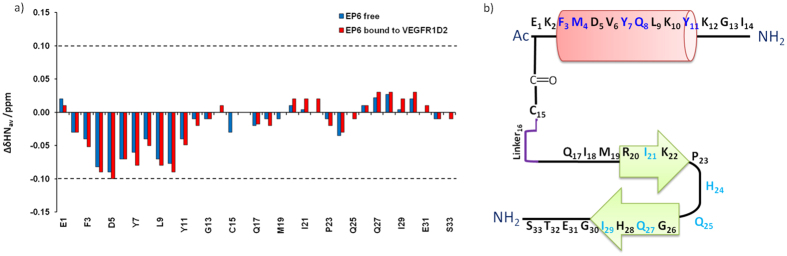
EP6 secondary structure.(a) Plot of the differences between the observed alpha proton chemical shifts and the corresponding random coil values (∆δHα) versus the amino acid sequence of free EP6 (blue) and of EP6 in the presence of VEGFR1D2 (red). (b) Sequence representation of EP6 secondary structure. Residues showing the biggest STD effects are highlighted in blue while those showing lower STD effects are highlighted in cyana.